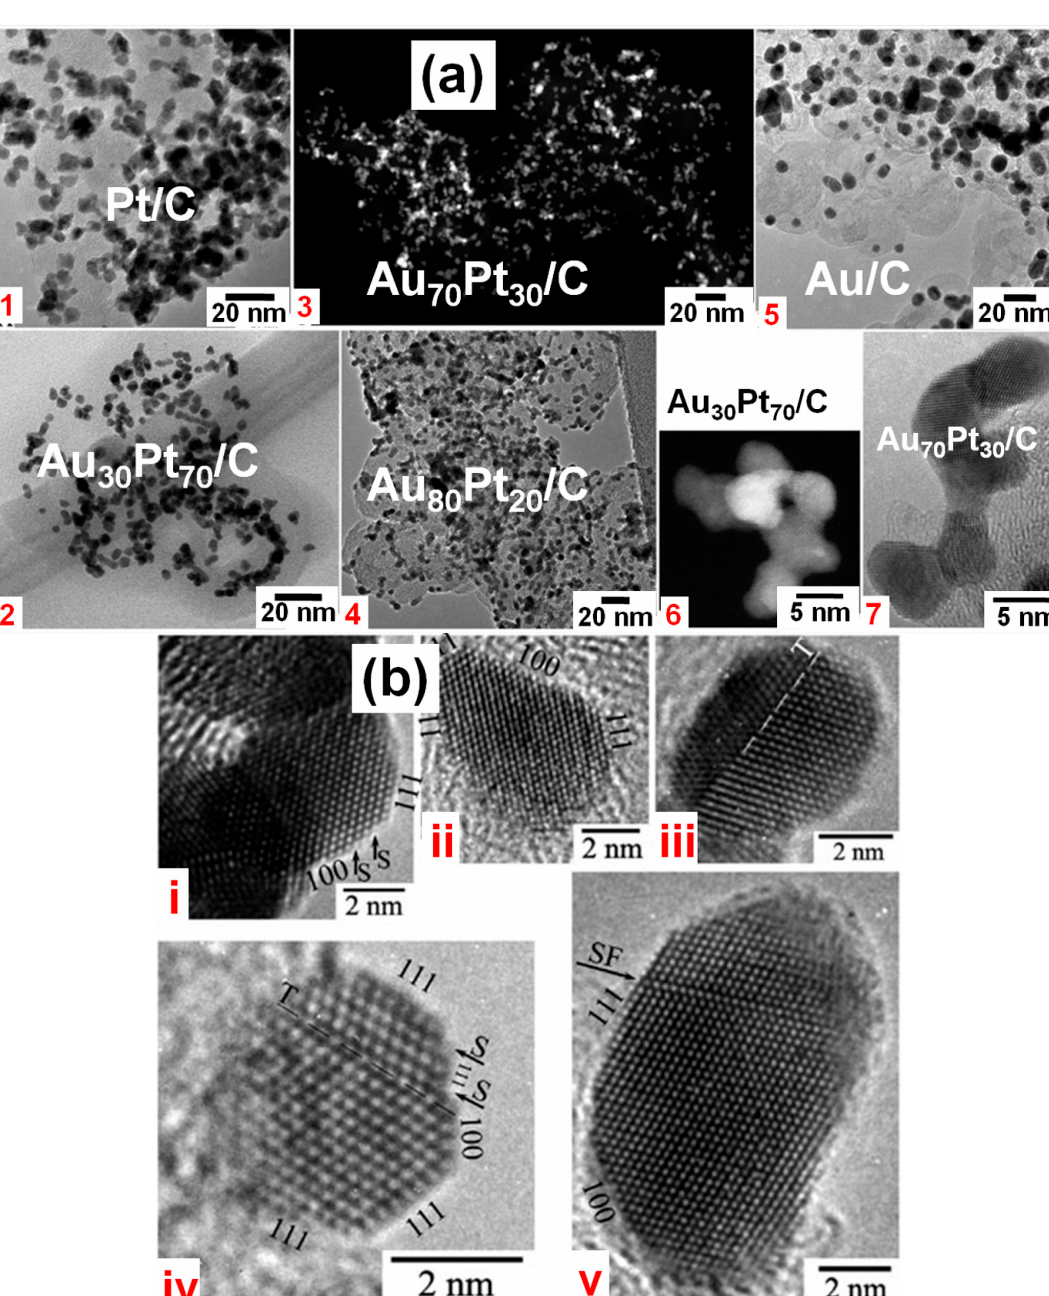
Figure 4. ( a ) TEM images of: (1) Pt/C, (2) Au 30 Pt 70 /C, (3) Au 70 Pt 30 /C, (4) Au 80 Pt 20 /C, (5) Au. Particle agglomerates are shown in (6) and (7) for Au 30 Pt 70 /C and Au 70 Pt 30 /C, respectively. ( b ) HRTEM images of (i and ii) Pt, (iii) Au 30 Pt 70 /C, (iv) Au 70 Pt 30 /C and (v) Au/C highlighting the facets, steps (S), twins (T) and stacking faults (SF). Note that the metal loading was 40 wt%. Reproduced and adapted in part from Ref. [54] with permission of the PCCP Owner Societies. Copyright 2009, Royal Society of